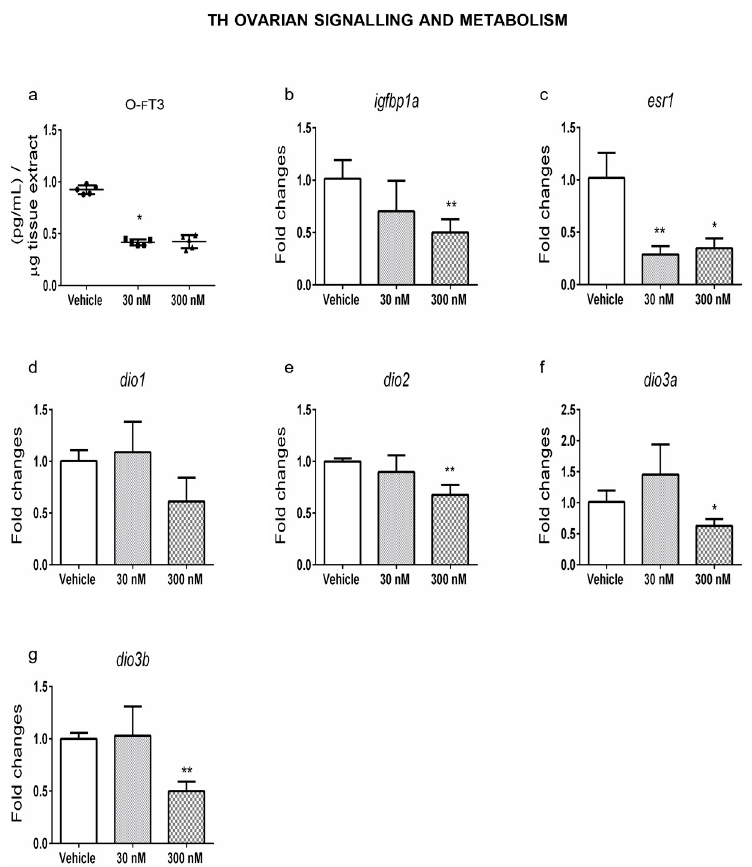
Figure 3. Exposure to CPF modulates THs levels and metabolism in zebrafish ovaries. ( a ) Ovarian fT3 levels (O-fT3) were measured by ELISA assay in adult ovaries from Vehicle and exposed females ( n = 5 ovaries/group), as described in M&M section. ( b – g ) Levels of the mRNAs of T3 responsive genes ( igfbp1a and esr1) and enzymes involved in THs metabolism ( dio1 , dio2, dio3a, and dio3b) in ovaries of zebrafish exposed to CPF. RT-qPCR tests were performed on five biological samples ( n = 5 ovaries/group). Data are reported as fold change values calculated as a ratio between average relative gene expression in exposed and control ovaries after normalization on tubaI mRNA. Significant differences are indicated with * p < 0.05 and ** p < 0.01 using Student’s t -test.